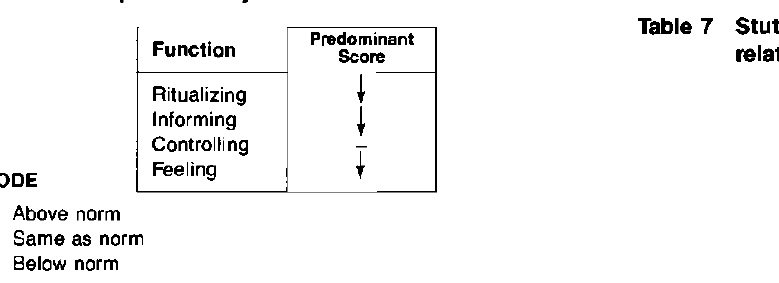
Table 4 Morpheme analysis related to the four functions